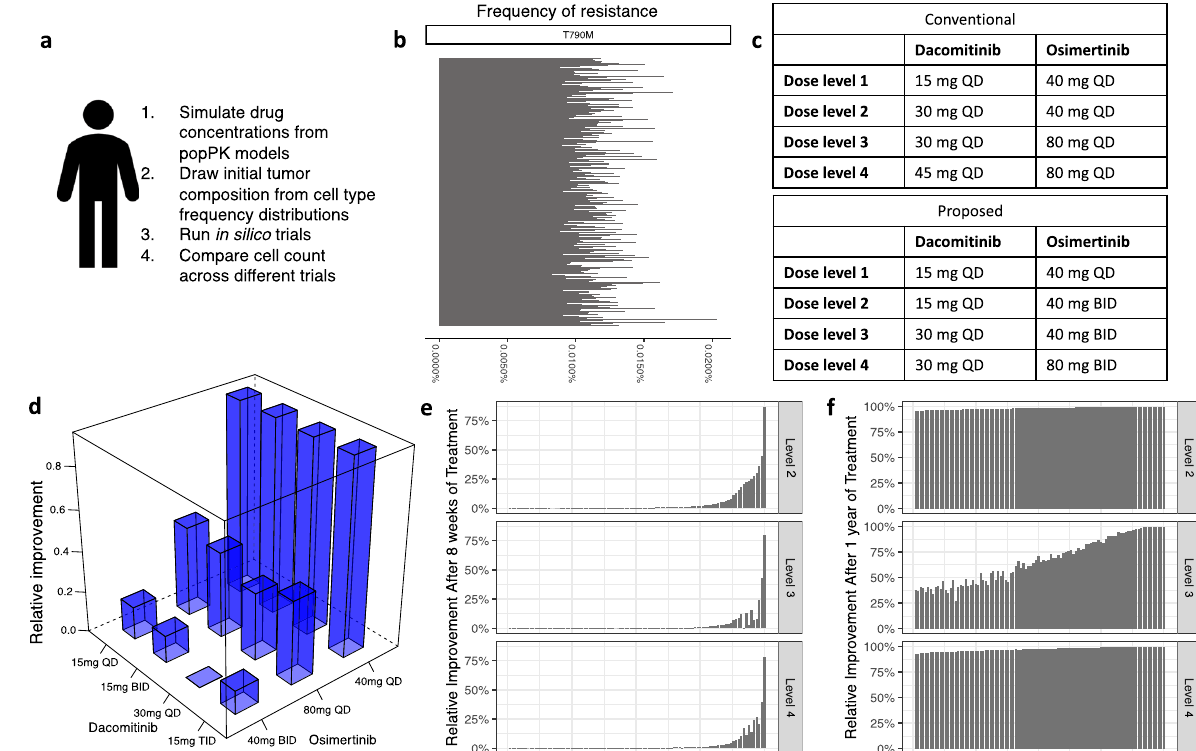
Fig. 3 In silico clinical trials of osimertinib and dacomitinib combination therapy. a Schematic overview of simulation steps comparison of dosing schedules for one individual. b Distribution of cell types before the initiation of the in silico trial over 1000 simulated patients (rows). c Conventional (top) and proposed (bottom) dose-escalation schedules to identify the MTD in a phase I study. d Comparison in outcomes of different schedules identi fi ed by their dacomitinib and osimertinib doses on the axes; the y axis is median improvement percentage of 30 mg QD of dacomitinib and 40 mg BID of osimertinib (proposed level 3 schedule) relative to each dose combination is shown after 1 year of treatment. e , f Waterfall plots with the relative improvement percentage of our proposed schedules compared to the conventional schedules after 8 weeks (2 treatment cycles) and 1 year of treatment, respectively, for 100